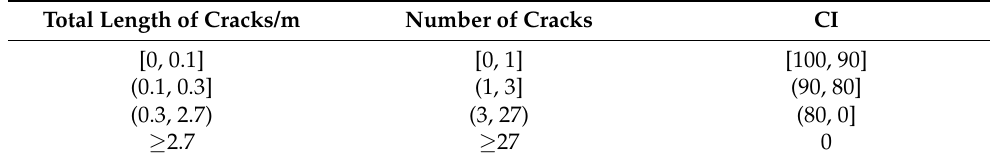
Table 4. Threshold of CI calculation.